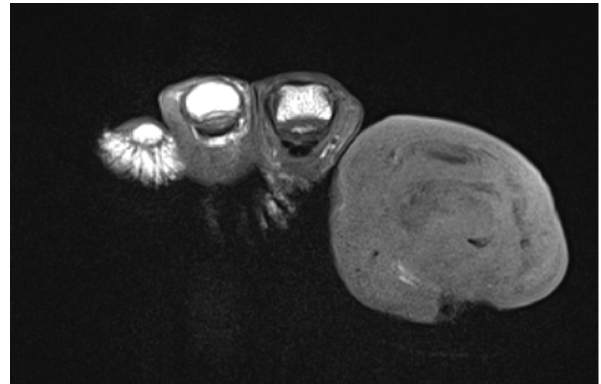
Figure 2. T1-weighted coronal images of the same case as in Fig. 1.